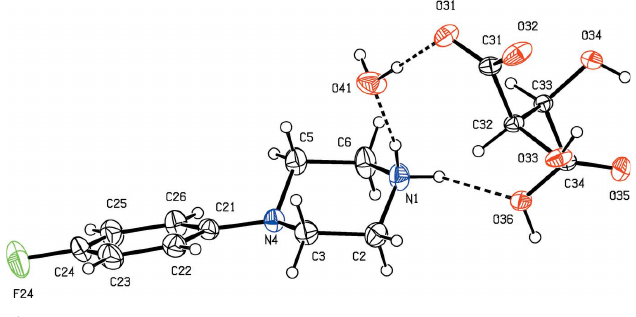
Figure 1 The independent components of compound (I) showing the atom- labelling scheme and the hydrogen bonds (drawn as dashed lines) within the asymmetric unit. Displacement ellipsoids are drawn at the 30% probability